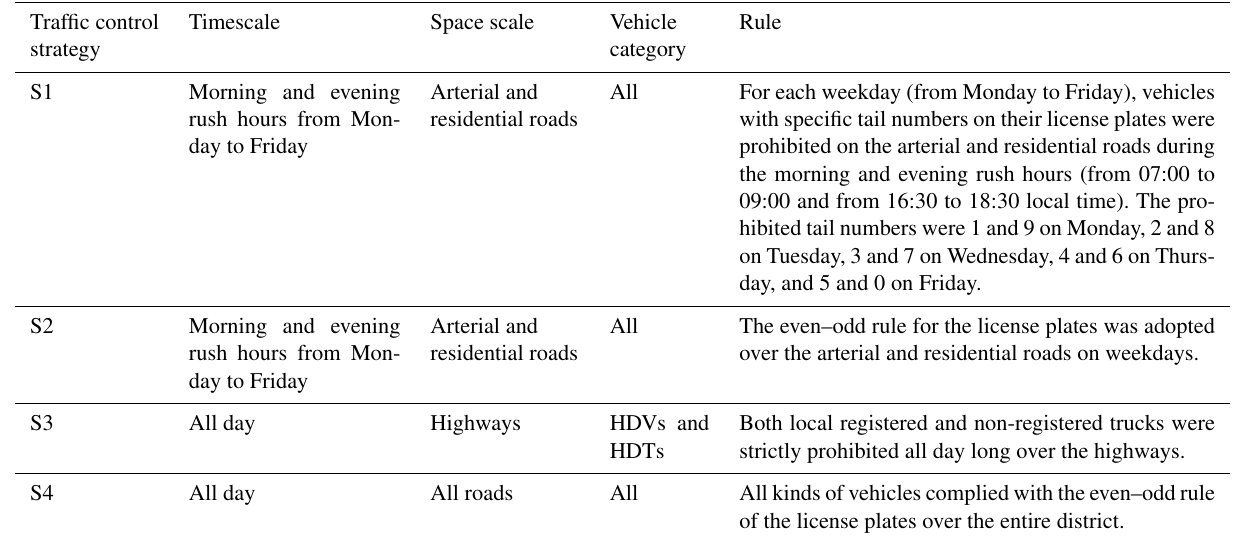
Table 1. Traffic control strategies. The detailed rules are presented spatially and temporally. Traffic control Timescale Space scale Vehicle Rule strategy